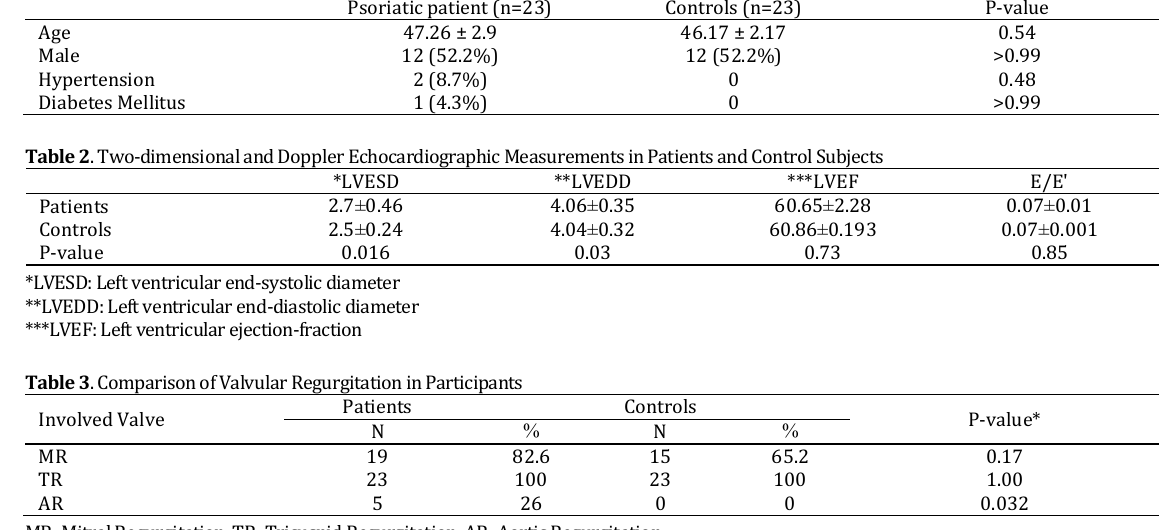
Psoriatic patient (n=23)